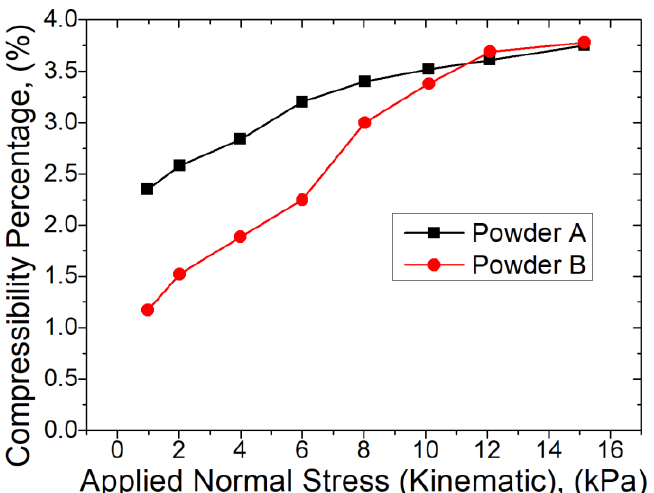
Figure 5. Comparison of compressibility characteristics exhibited by Powders A ( ■ ) and B ( ).